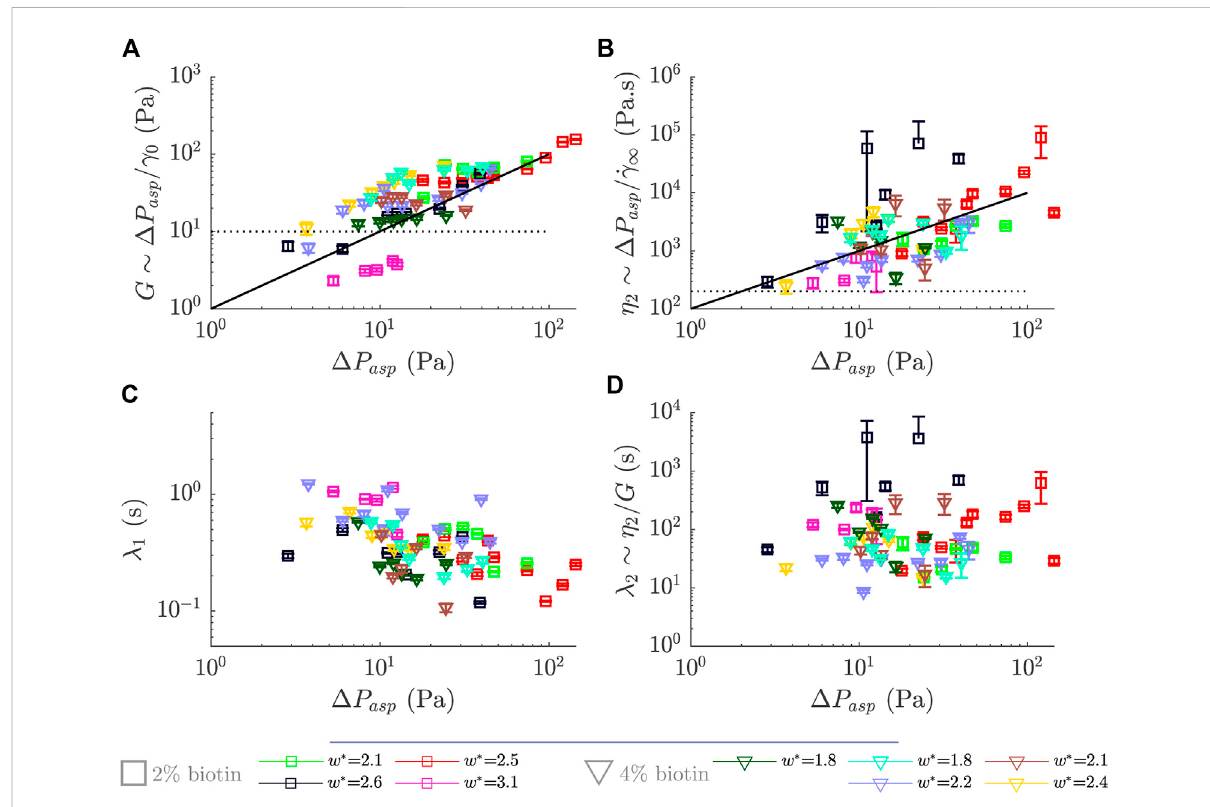
FIGURE 5 Rheological parameters obtained for different prototissues with different biotin compositions and sizes as a function of the applied steps in pressure, Δ P asp . (A) Effective elastic modulus, G (B) Effective viscosity, η 2 . (C) Retardation time, λ 1 . (D) Relaxation time de fi ned as the ratio λ 2 ~ η 2 / G . Error bars were obtained by propagating the errors obtained over the fi tting